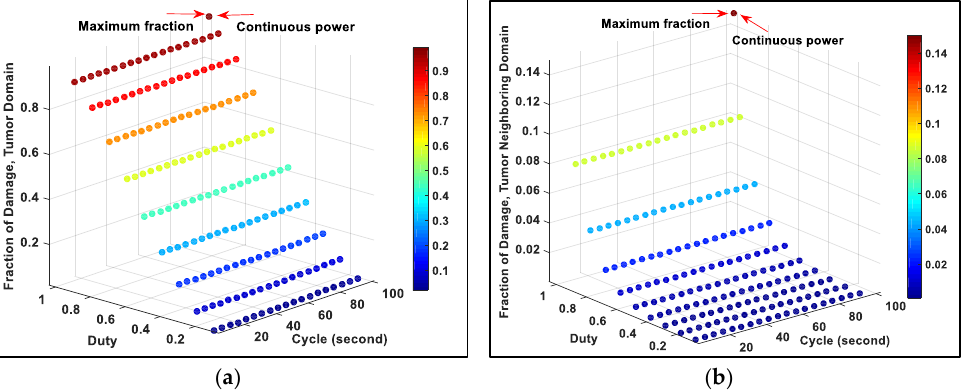
Figure 2. Fraction of tissue damage at ( a ) tumor domain and ( b ) tumor neighboring domain for source diameter of 2 mm for pulsed and continuous powers for 30-min simulations.